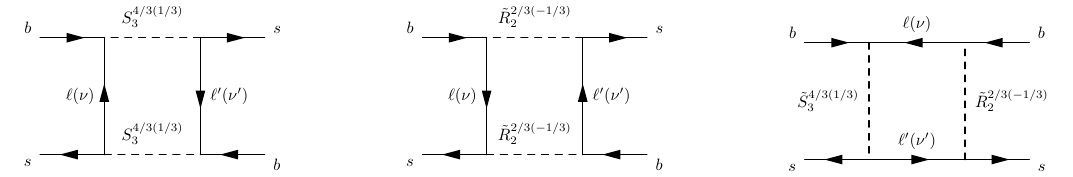
~ R 3 and 2 contributing to (cid:1) m s